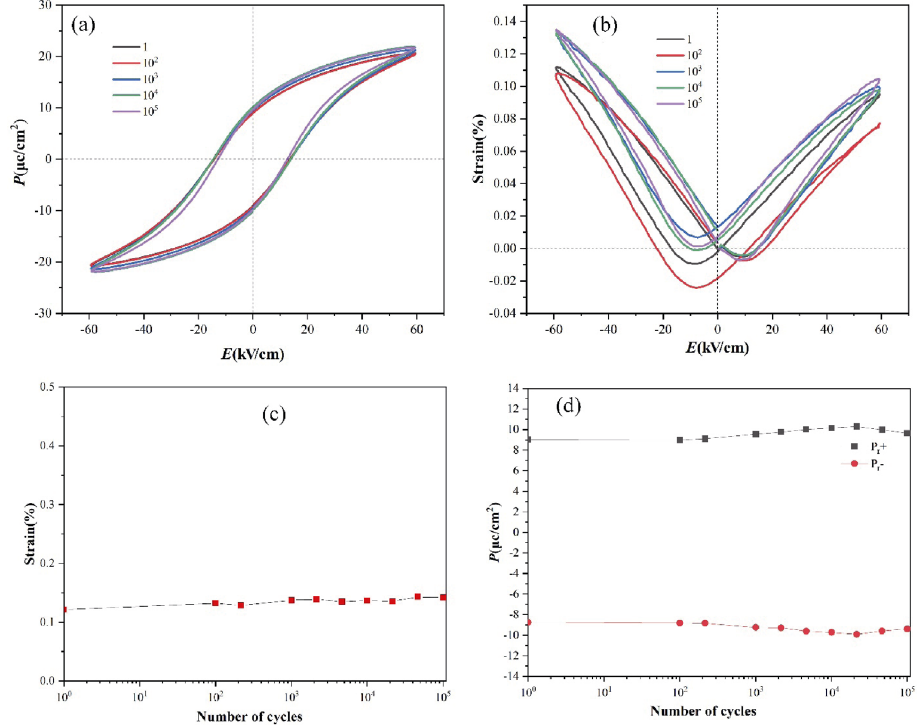
Fig. 6 Bipolar fatigue behavior of (a) P–E and (b) S–E for ergodic relaxor KNSN–0.04BNKZ– x Sm ( x = 0.002) ceramics, at 10 Hz for 10 5 cycles. (c) Unipolar strain values for the above sample as a function of switching cycle. (d) Remanent polarization P r for the above sample as a function of switching